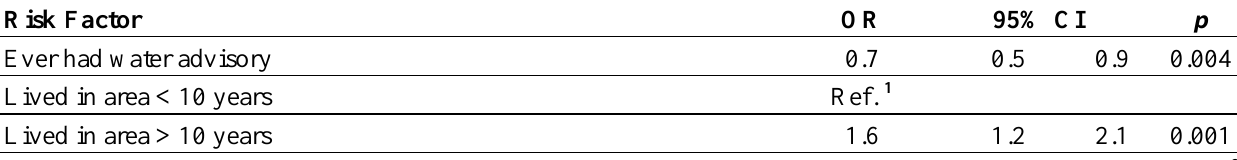
Table 4. Risk factors included in final multivariable model for daily consumption of tap